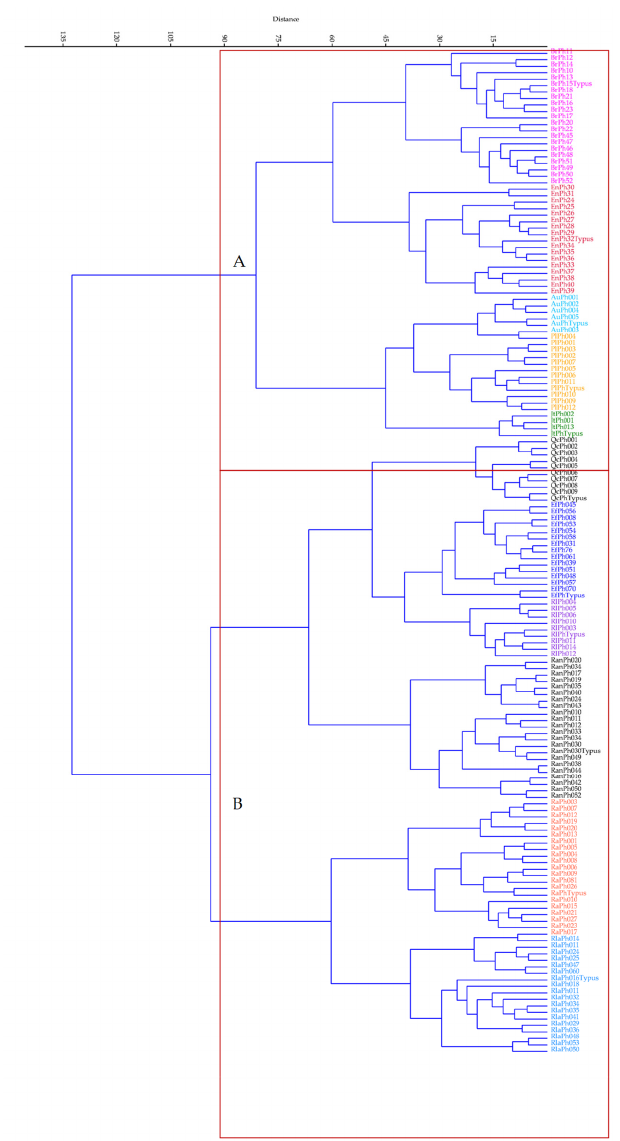
Figure 1. Cluster analysis of Pinus halepensis Mill. relevés corresponding to the associations in the study. ( A ) Associations in the north-east of the Iberian Peninsula: BrPh = Bupleuro rigidi-Pinetum halepensis , EnPh = Ephedro nebrodensis-Pinetum halepensis , AuPh = Arbuto unedi-Pinetum halepensis , PlPh = Pistacio lentisci-Pinetum halepensis (= Ceratonio siliquae-Pinetum halepensis ), JtPh = Junipero turbinatae-Pinetum halepensis . ( B ) QcPh = Querco cocciferae-Pinetum halepensis ; EfPh = Ephedro fragilis- Pinetum halepensis ; RlPh = Rhamno lycioidis-Pinetum halepensis ; RlaPh = Rhamno laderoi-Pinetum halepen- sis ; RanPh = Rhamno angustifoliae-Pinetum halepensis ; RaPh = Rhamno almeriensis-Pinetum halepensis